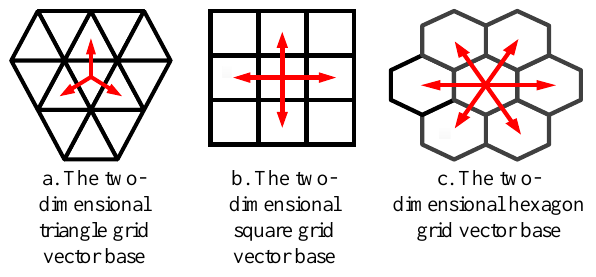
Figure 2. Schematic diagram of the direction vector